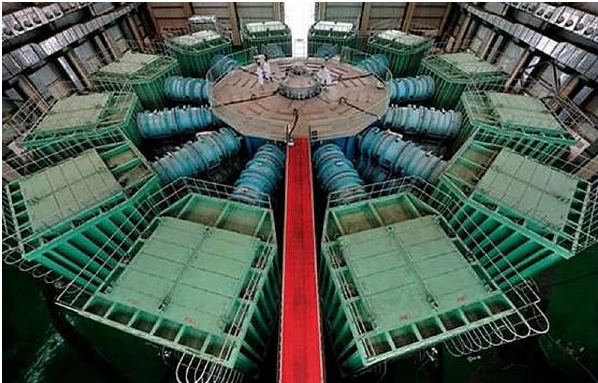
FIG. 1. Layout of the PTS facility. Twelve oil tanks (the outer most in light green) contain twenty-four Marx generators. The coaxial sections (middle in light blue) include twenty-four sets of intermediate storage, laser triggered gas switches and pulse forming lines. They are in two layers, twelve modules in each layer. In the center is the water tank and vacuum chamber. The red strip between the tanks is an